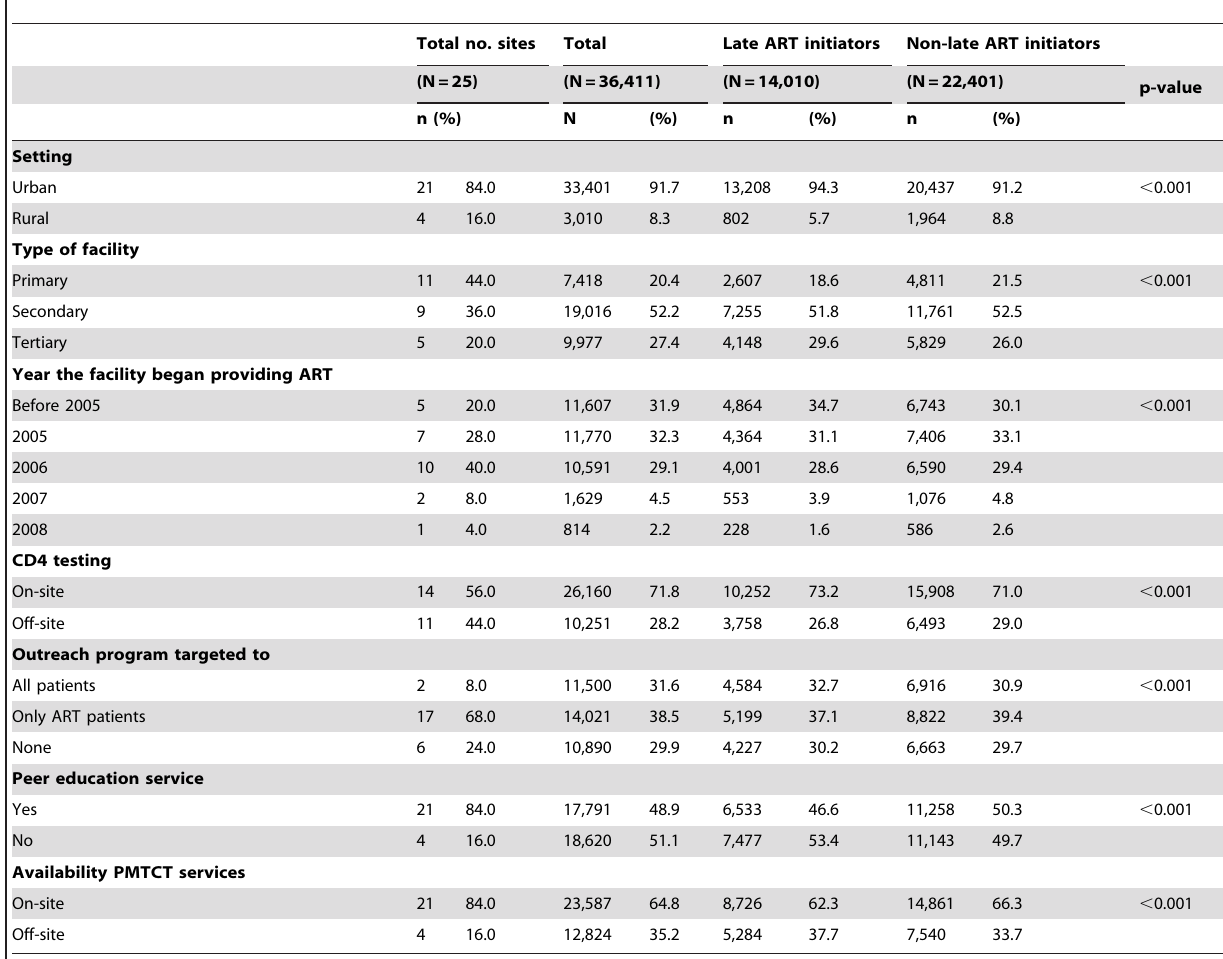
Table 2. Clinic and program characteristics of sites where patients started ART stratified by